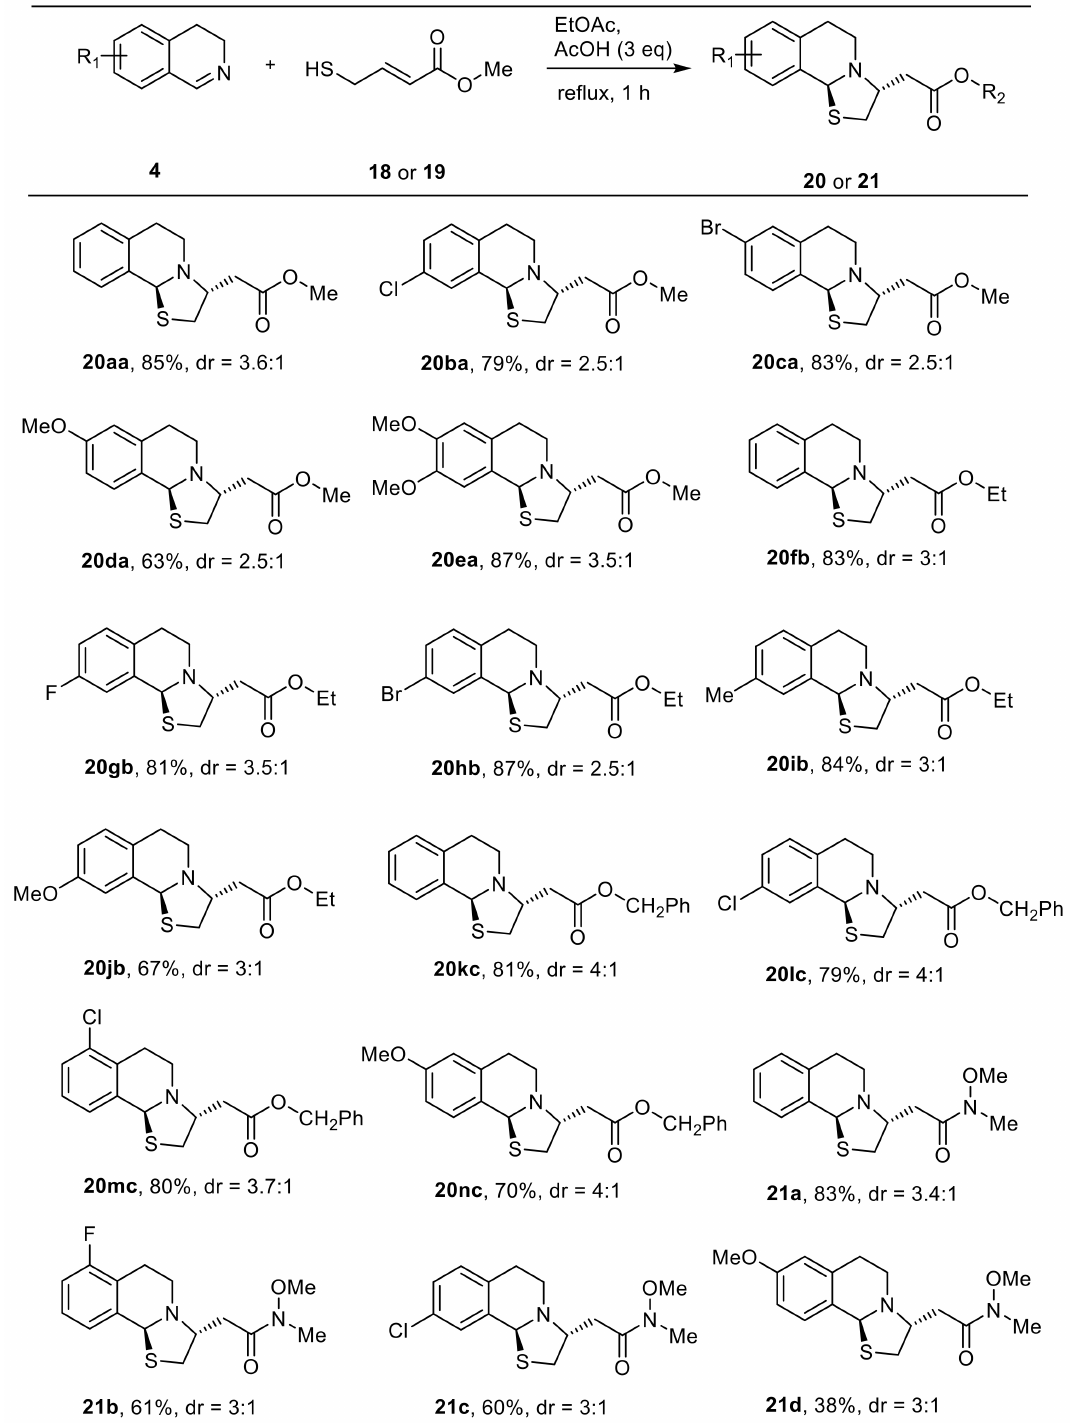
Figure 2. Scope of the addition of 3,4-dihydroisoquinolines with γ -mercapto- α , β -unsaturated esters and-unsaturated